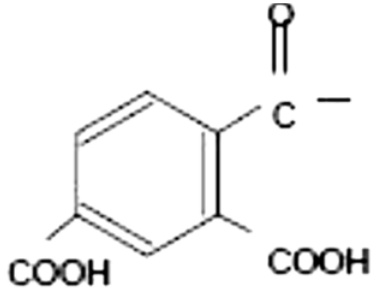
Figure 2. Represents the chemical structure of CAT